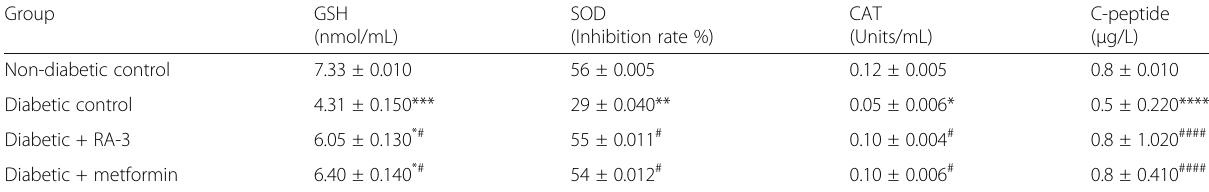
Table 2 Effect of RA-3 on serum antioxidants and C-peptide levels of the diabetic animals Group GSH